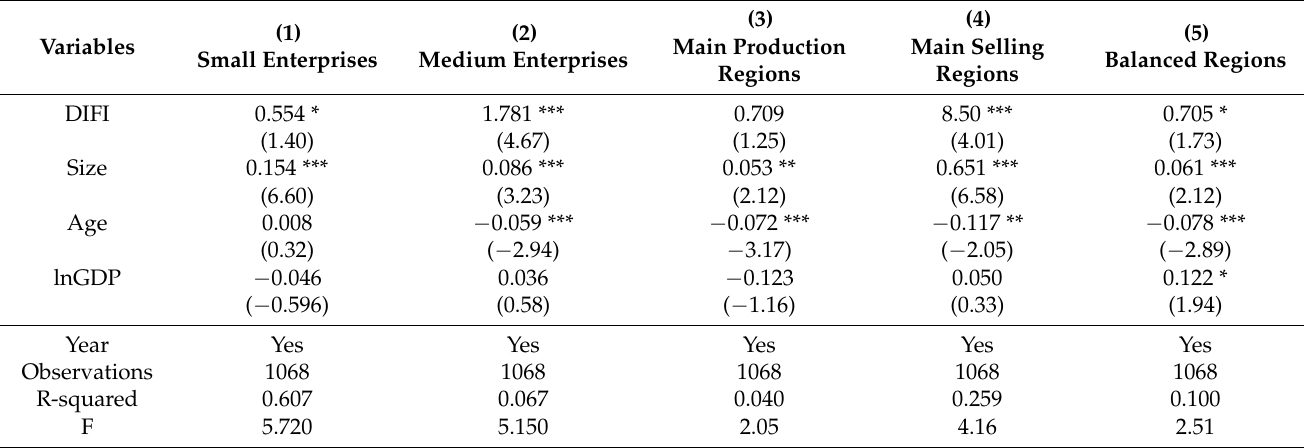
Table 4. The impact of digital inclusive finance on operating income according to different sizes of enterprises and functioning